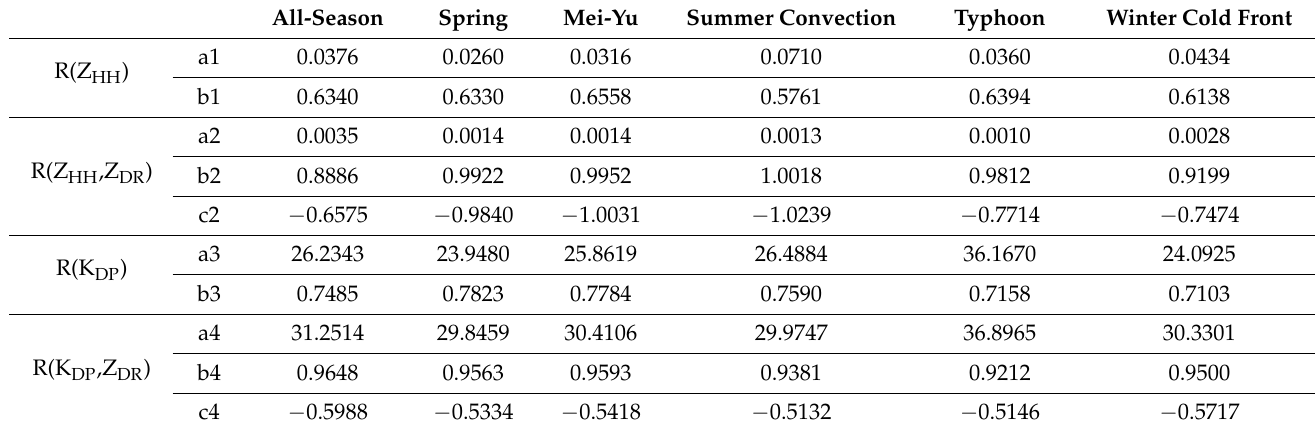
Table 3. Same as Table 2 but for C-band